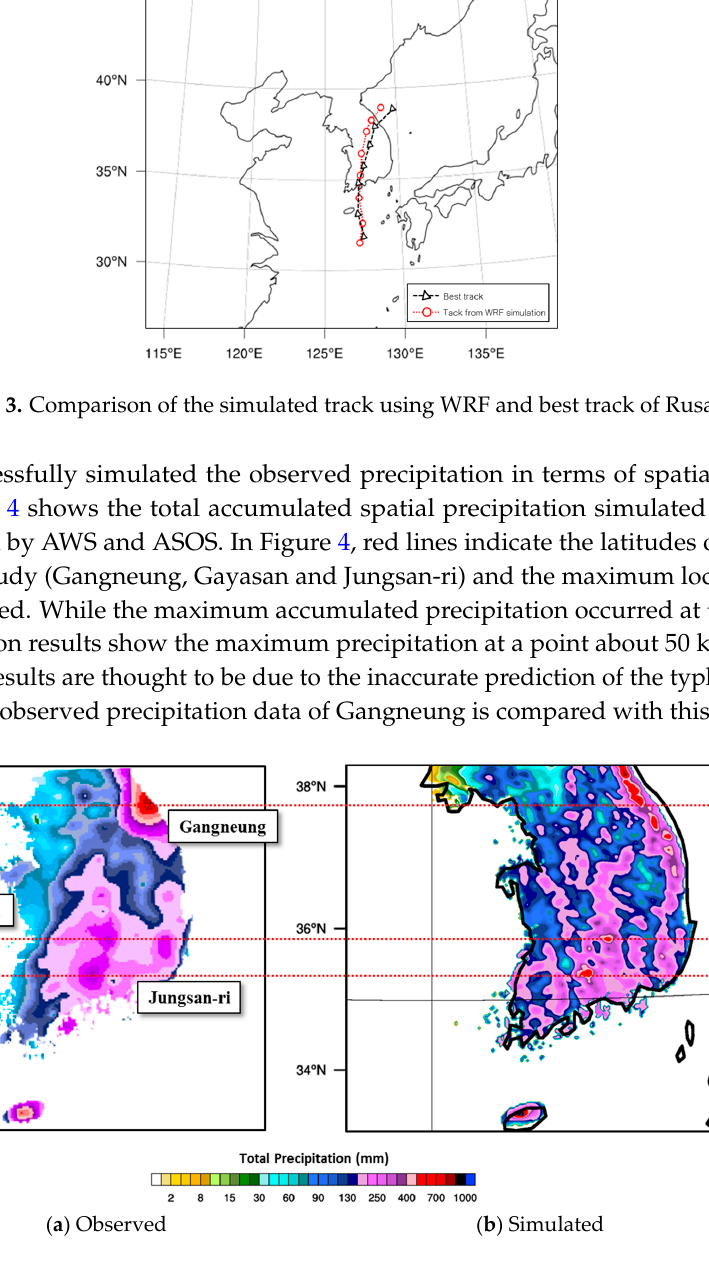
Figure 4. Comparison of observed and simulated total accumulated precipitation.